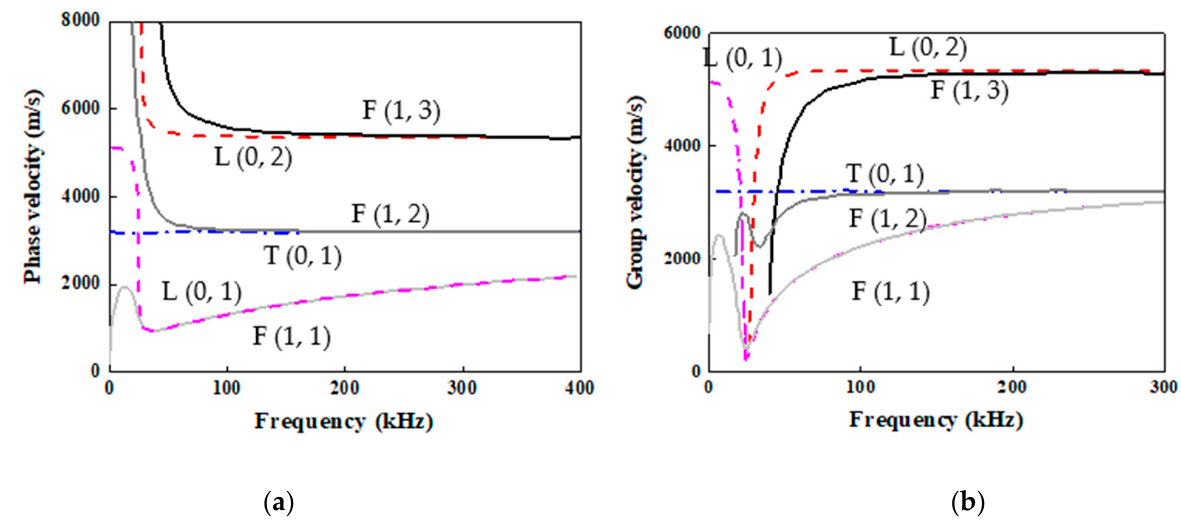
Figure 2. Phase velocity and group velocity. ( a ) Phase velocity. ( b )Group velocity